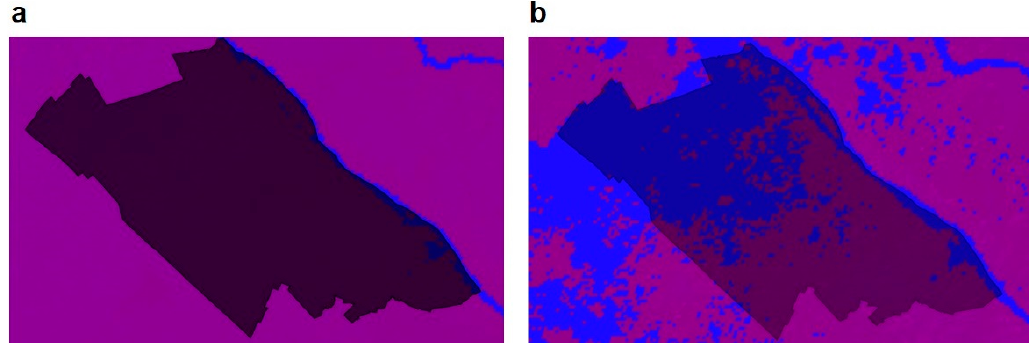
Figure 6. False color Terra Moderate Resolution Imaging Spectroradiometer (MODIS) image showing the study area during ( a ) dry season and ( b ) flood season. Sentinel-2